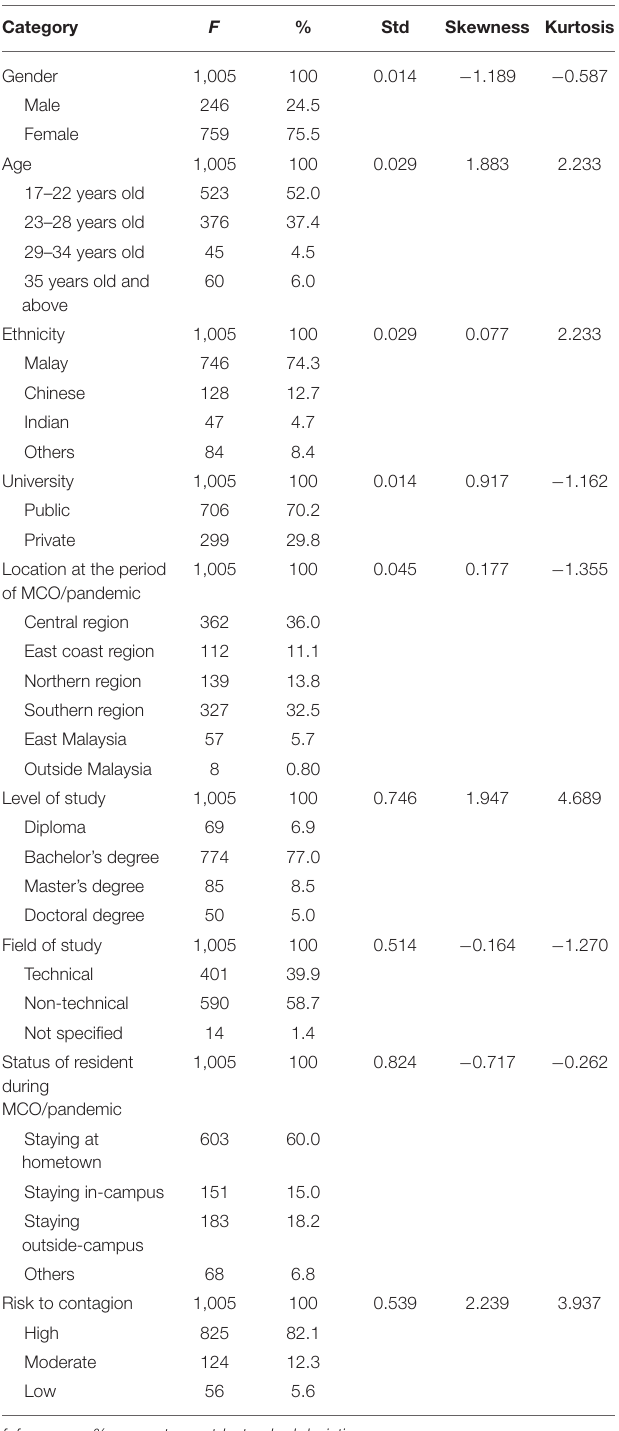
TABLE 1 | Respondents’ demographic characteristics ( N = 1,005).